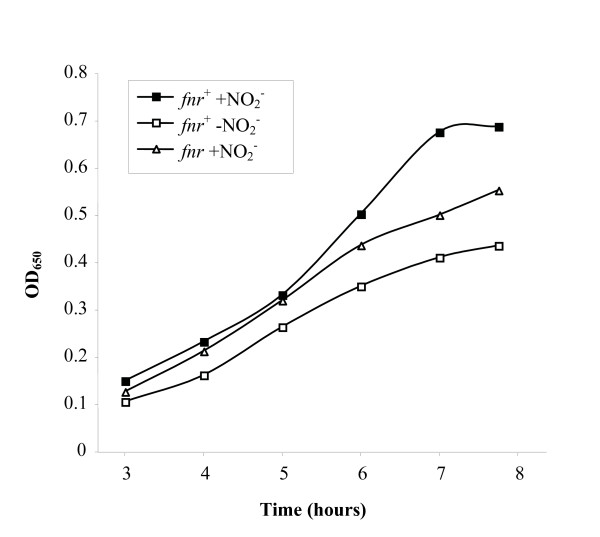
Growth characteristics of strain RUG7001 (fnr+) in the presence and absence of 5 mM sodium nitrite and strain RUG7002 (fnr) in the presence of nitrite. Since expression of the nitrite reductase AniA is dependent upon FNR, the fnr strain cannot respire nitrite.